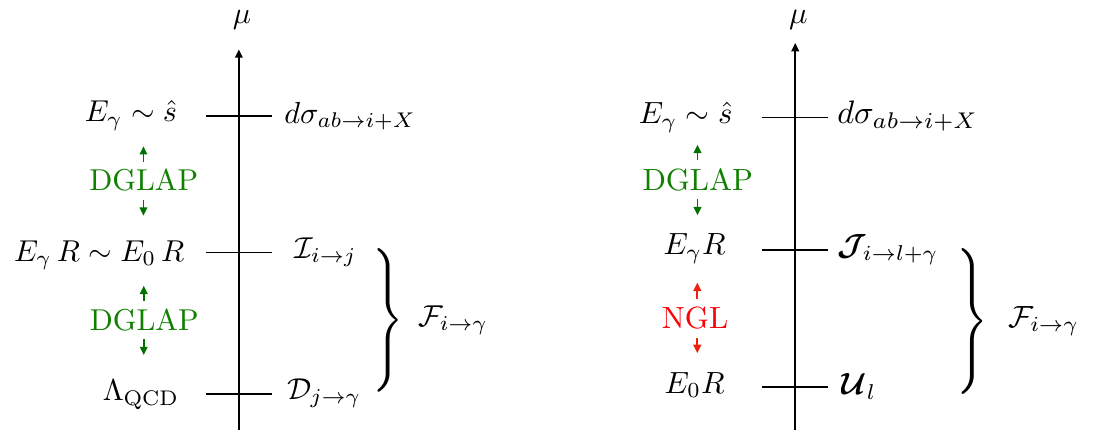
Figure 2 . The scales arising in the factorization theorems (2.1) and (5.1), together with the type of RG evolution needed to resum the associated logarithms. On the left we show the factorization when R is small and the isolation energy E 0 is parametrically of the same size as the photon energy E γ . On the right we show the factorization for R (cid:28) 1 and (cid:15) γ = E 0 /E γ (cid:28) 1 . In this limit non-perturbative fragmentation effects are suppressed by (cid:15) γ